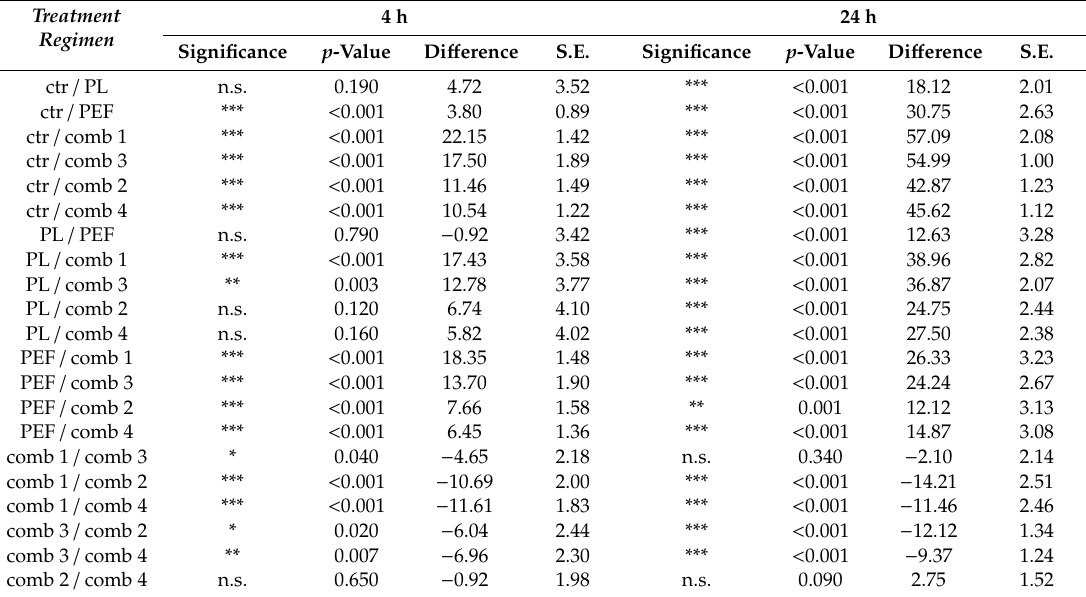
Table 3. Statistical analysis of metabolic activity 4 and 24 h after treatment. A multiple t-test was performed (* p < 0.05; ** p < 0.01; and *** p < 0.001). ctr = control; PL = plasma; PEF = pulsed electric fields; comb = combination; n.s. = not